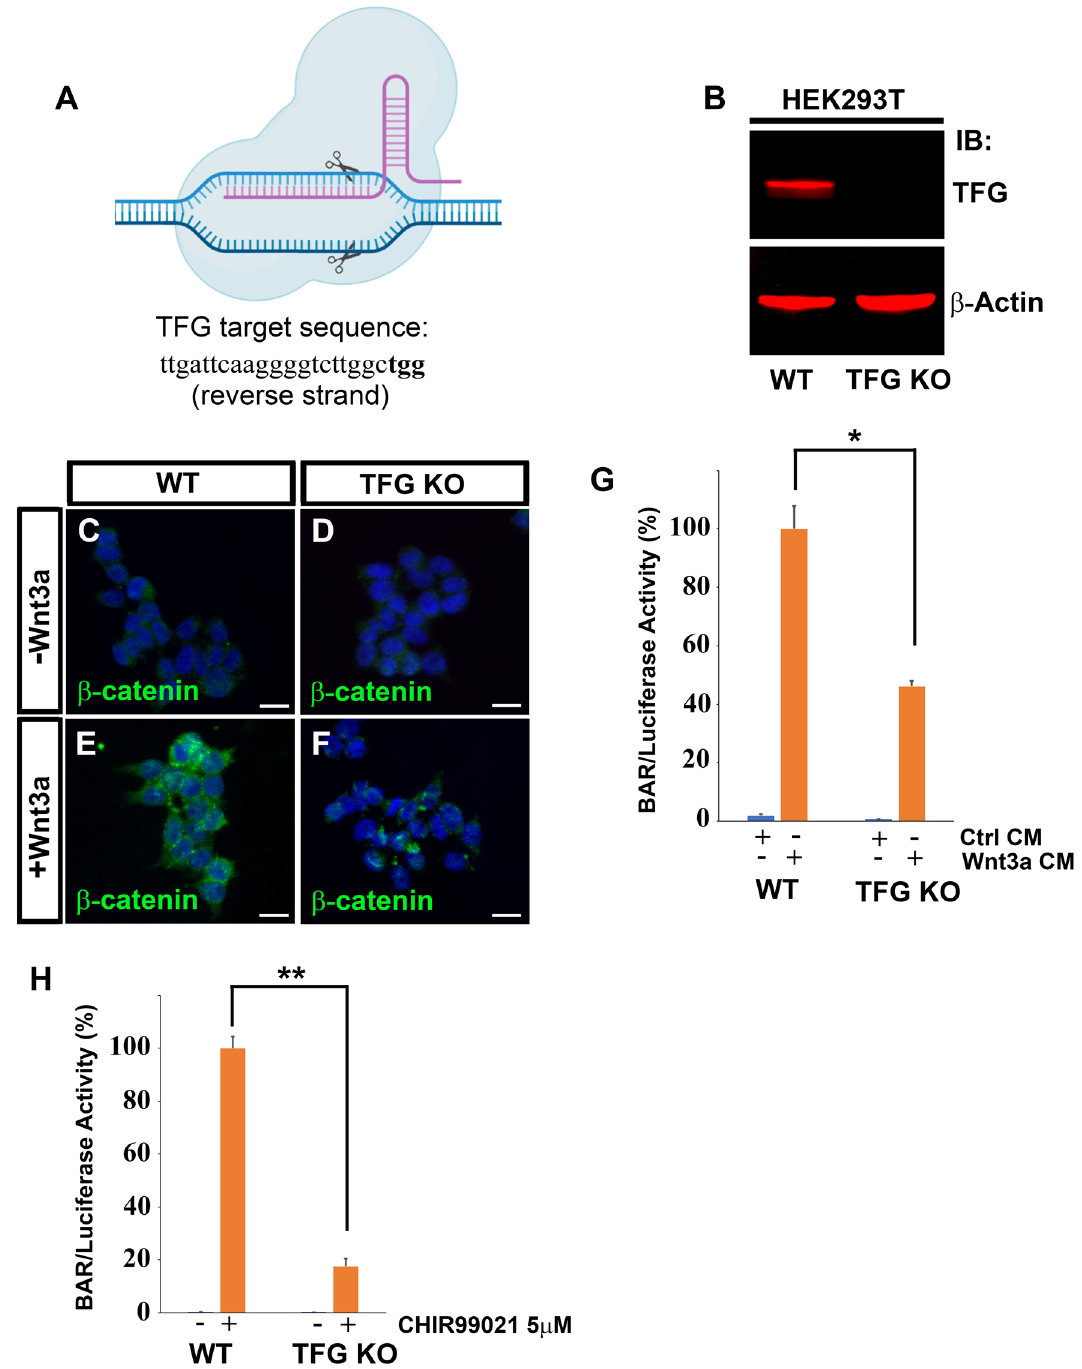
Figure 4. CRISPR-Cas9 mediated TFG knock-out inhibits Wnt-dependent β-catenin stabilization and Wnt-induced reporter activity. ( A ) Schematic diagram of Cas9 cleaving the TFG genomic DNA target sequence. The target sequence (which is on the reverse strand) is shown in 5 ′ –3 ′ orientation (left–right); the PAM (protospacer adjacent motif) sequence is in bold. ( B ) Western blot of HEK293T cells confirming complete elimination of TFG protein in Cas9 knock-out cells. β-actin was used as loading control. ( C – F ) Immunostaining for β-catenin on WT or TFG KO cells. Cells were treated with control conditioned medium or with Wnt3a conditioned medium for 3 h before immunostaining. Note that TFG knock-out decreases Wnt3a-induced β-catenin accumulation; DAPI was used for nuclear counter-staining. Scale bars represent 20 µm. ( G ) Cas9-mediated TFG knock-out reduces response to Wnt3a by 50% in HEK293T BAR/Renilla β-catenin reporter cells. Cells were treated with Wnt3a or control medium for 16 h before luciferase analysis. ( H ) Luciferase assay of HEK293T BAR reporter cells treated with the GSK3 inhibitor CHIR99021 at 5 µM concentration for 16 h before being processed for luciferase assay. Note that TFG KO causes an 80% reduction of β-catenin luciferase activity in response to the GSK3 inhibition. Error bars represent standard deviation from triplicate experiments. Statistical significance was calculated with a paired 2-tailed t-Student test. *P < 0.05; **P <